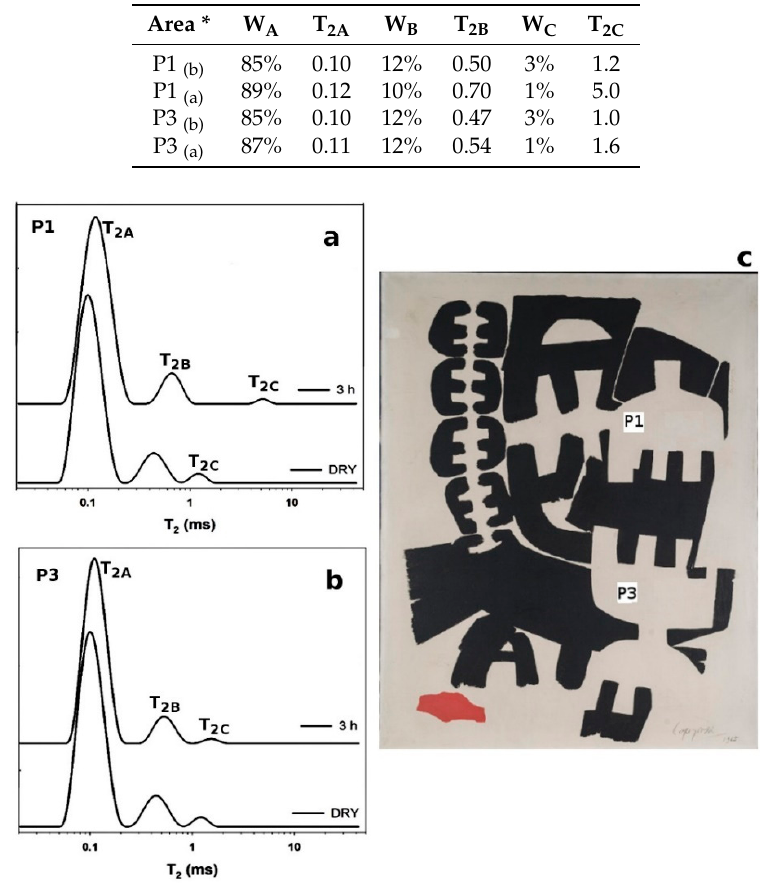
Table 1. Values of T 2 eff (ms) measured in oil painting before and after the application of cleaning treatments. W indicates the normalized population of proton density (%). * (b) = before the cleaning treatment; (a) = after the cleaning treatment.